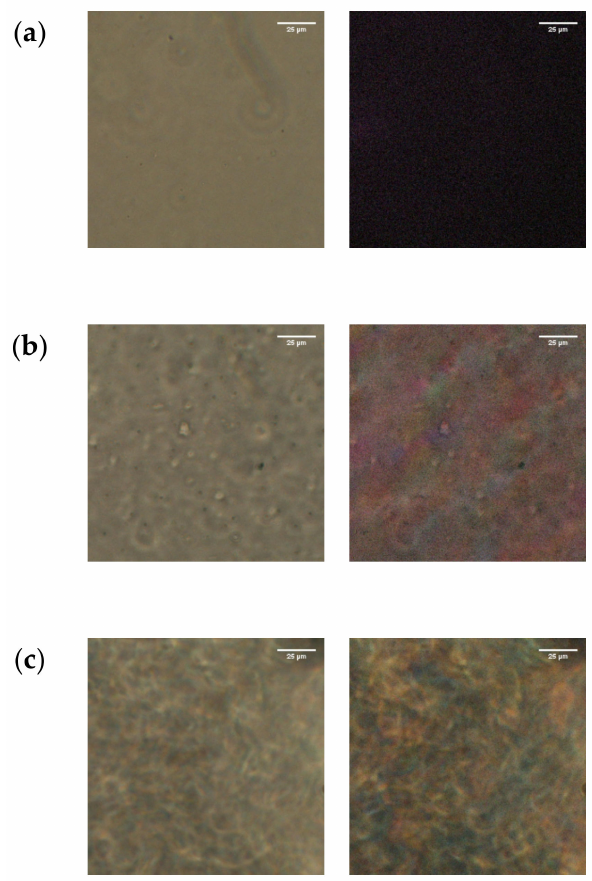
Figure 4. Optical micrographs for the PC 4 -TFSI/LiTFSI mixtures with w LiTFSI = 0.3 ( a ), 0.4 ( b ), 0.5 ( c ). The left- and right-hand pictures are respectively the bright-field micrographs and the cross-polarized micrographs, in which the polarizer and the analyzer were set in horizontal and vertical directions, respectively. The scale bar in each figure is 25 µ